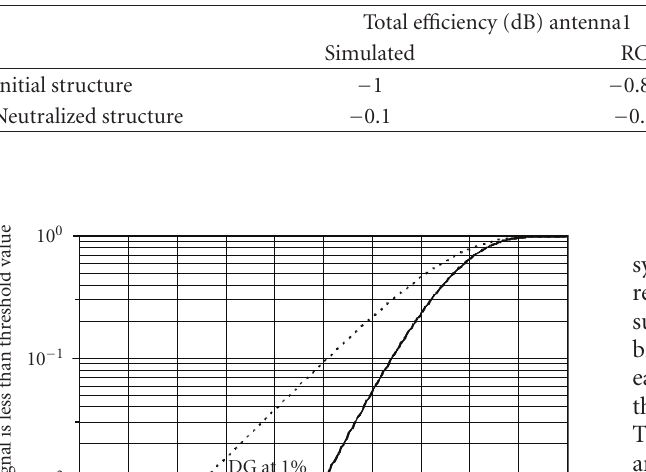
Table 3: Simulated (3D pattern integration or IE3D values) and measured total e ffi ciency of each antenna of the di ff erent antenna systems.